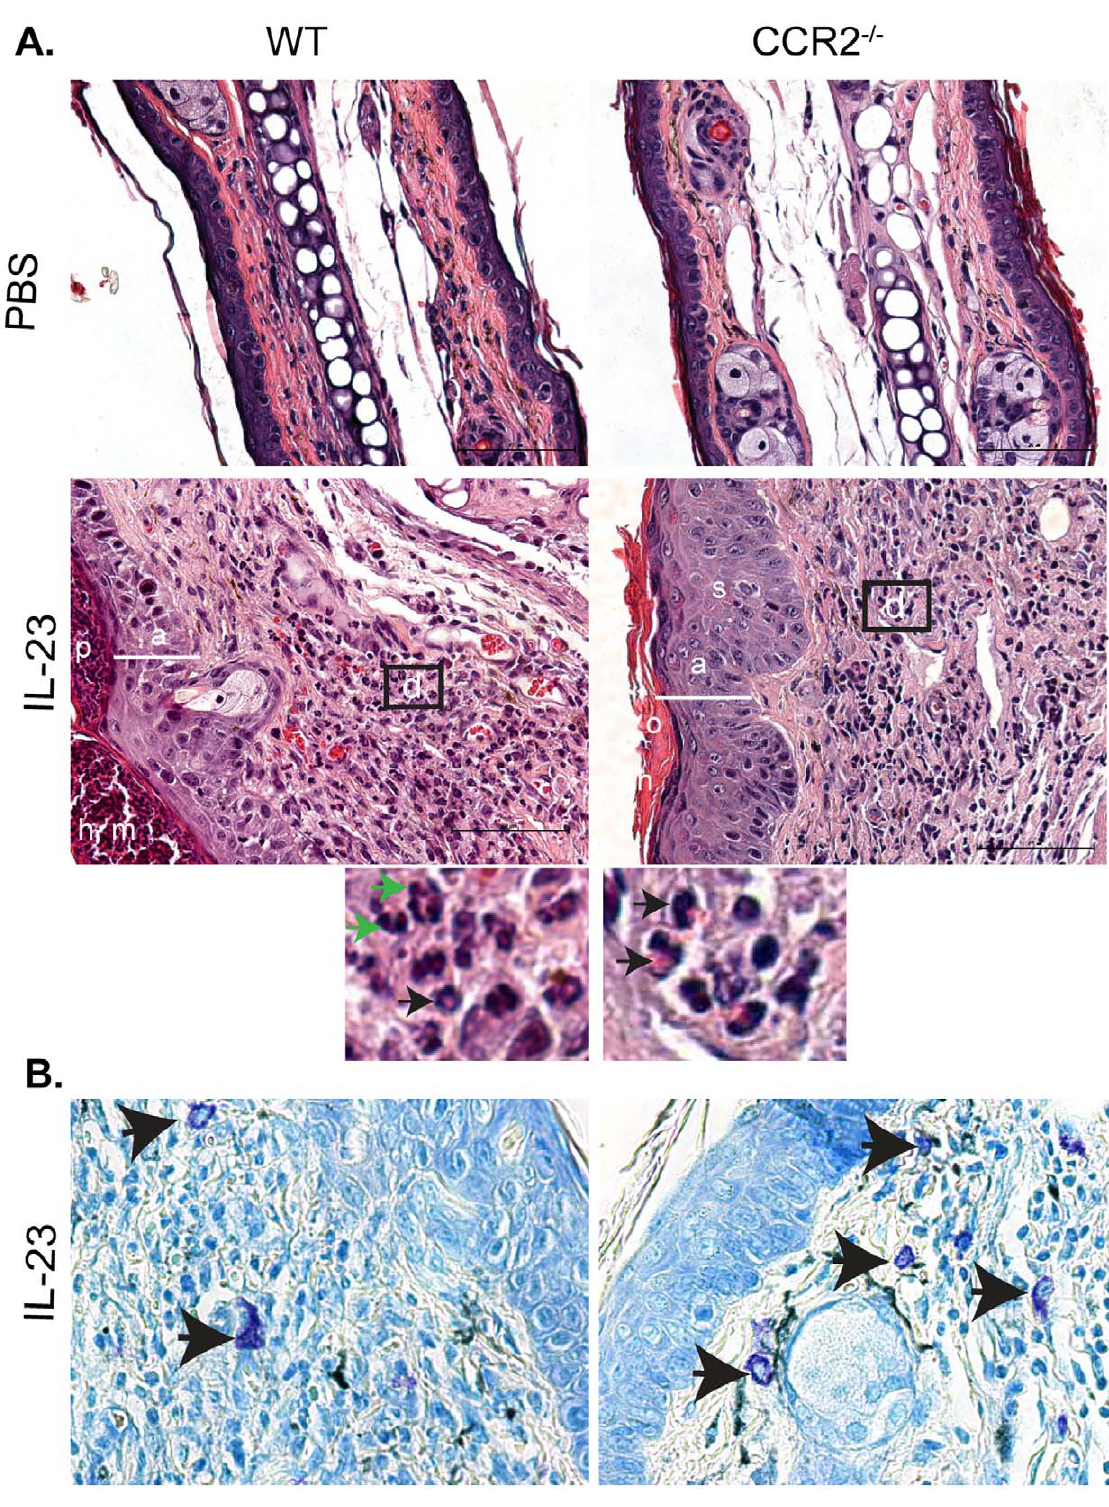
Figure 2. Eosinophils and mast cells accumulate in ears of IL-23-injected CCR2 2 / 2 mice. ( A ) H&E-stained sections of ears from IL-23- injected WT and CCR2 2 / 2 mice at day 12. a, acanthosis; h, hyperkeratosis; p, parakeratosis; o, orthokeratosis; d, dermal inflammatory infiltrate; s; spongiosis; m, intracorneal microabscess. Enlargements of the boxed areas within the WT IL-23 or CCR2 2 / 2 IL-23 image are displayed below the corresponding photo. Black arrows indicate eosinophils. Green arrows indicate neutrophils. ( B ) Toluidine blue-stained sections of ear from IL-23- injected WT and CCR2 2 / 2 mice at day 12. Arrows indicate mast cells.